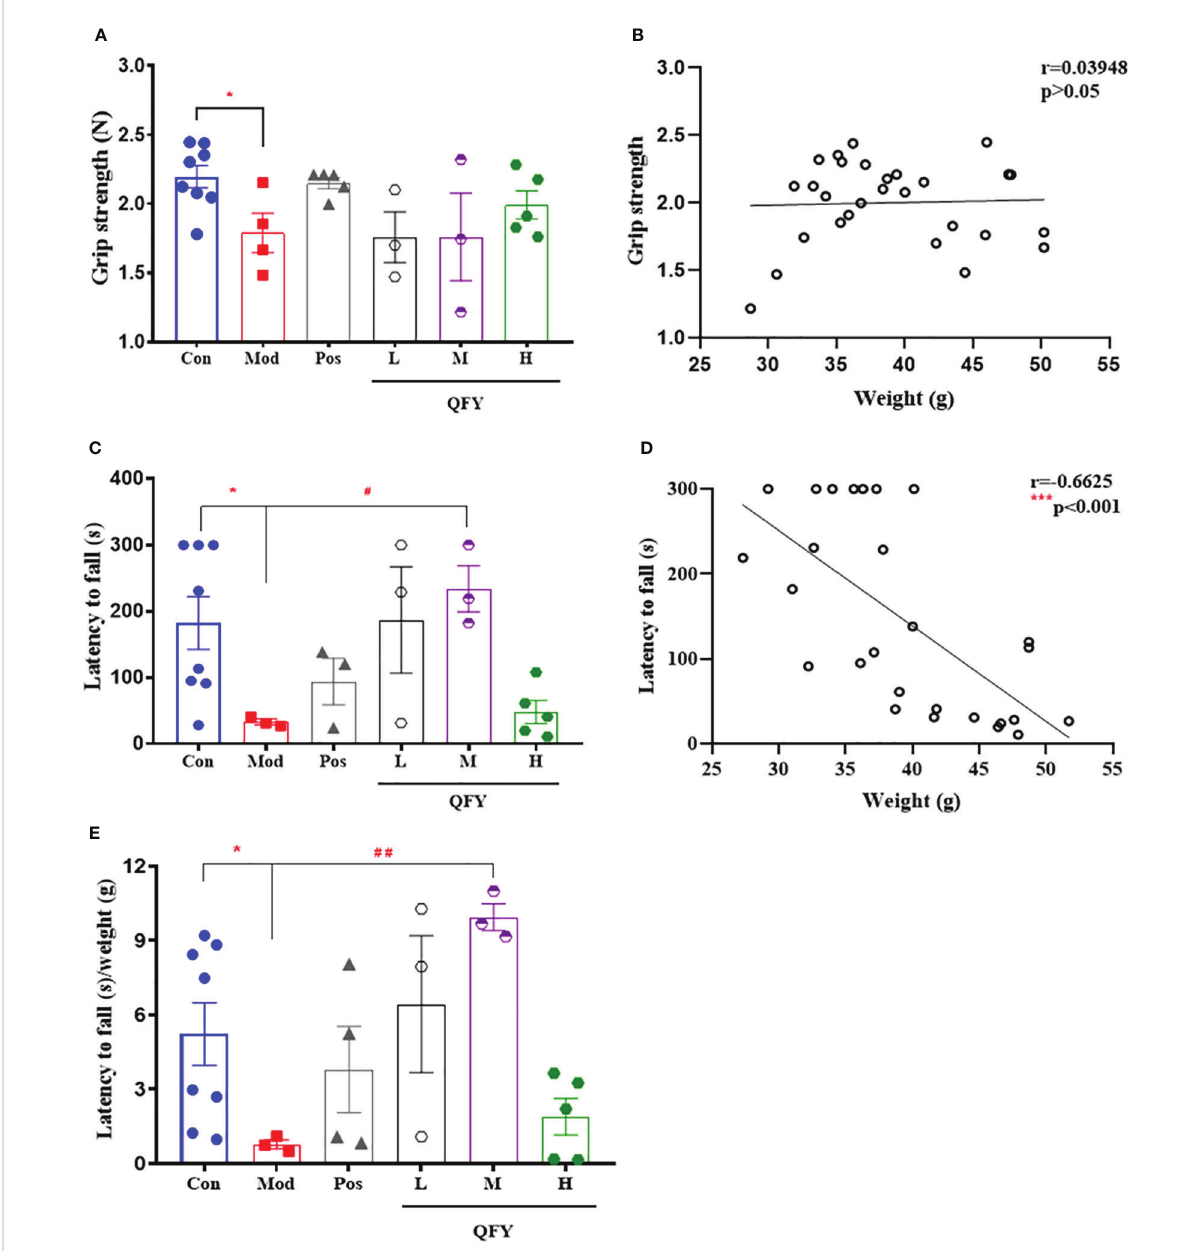
FIGURE 4 Effects of Qi-Fu-Yin on the ability of grip strength and the limb strength of APP/PS1 transgenic mice. Grip strength test (A, B) and Rotarod test (C – E) . (A) Grip strength, (B) The correlation between grip strength and body weight, (C) latency to fall, (D) The correlation between latency to fall and body weight, (E) latency to fall/weight. Mean ± SEM, n=3~8, * P <0.05, vs control (Con) group, unpaired Student`s t-test, # P <0.05, ## P <0.01, vs model (Mod) group, one-way ANOVA analysis followed by Dunnett ’ s multiple comparisons test, *** P <0.001, Pearson correlation analysis, Graphpad Prism8.0.1